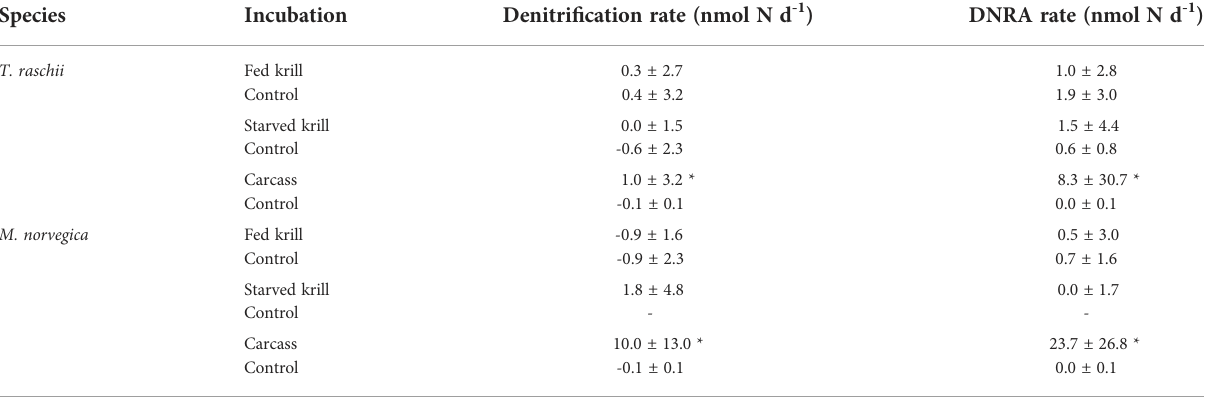
TABLE 1 Mean ± SD rates of denitri fi cation and dissimilatory nitrate reduction to ammonium (DNRA) production in live krill (fed and starved) (n= 5), and carcasses (n= 6-7) of Thysanoessa raschii and Meganyctiphanes norvegica .